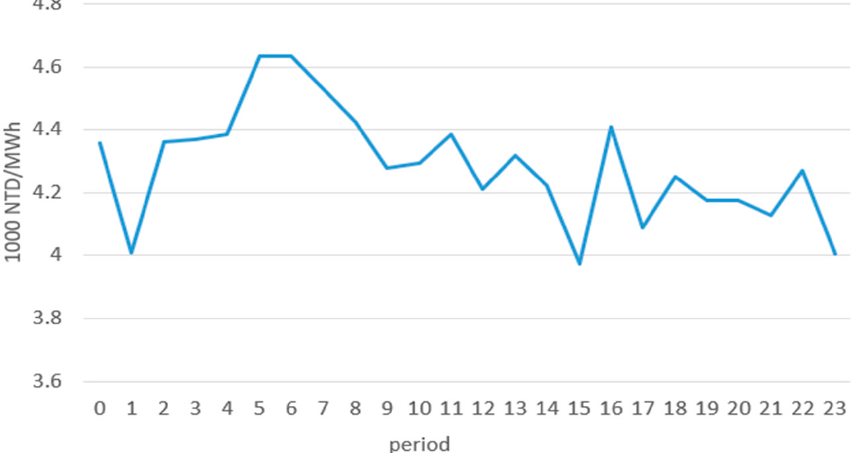
Figure 7. Hourly power generation cost for the day with minimum load (case 1).